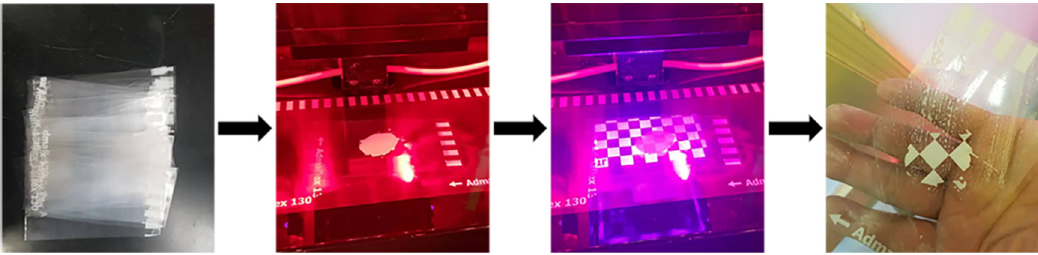
Figure 2. The illustration of the cure depth measurement principle.